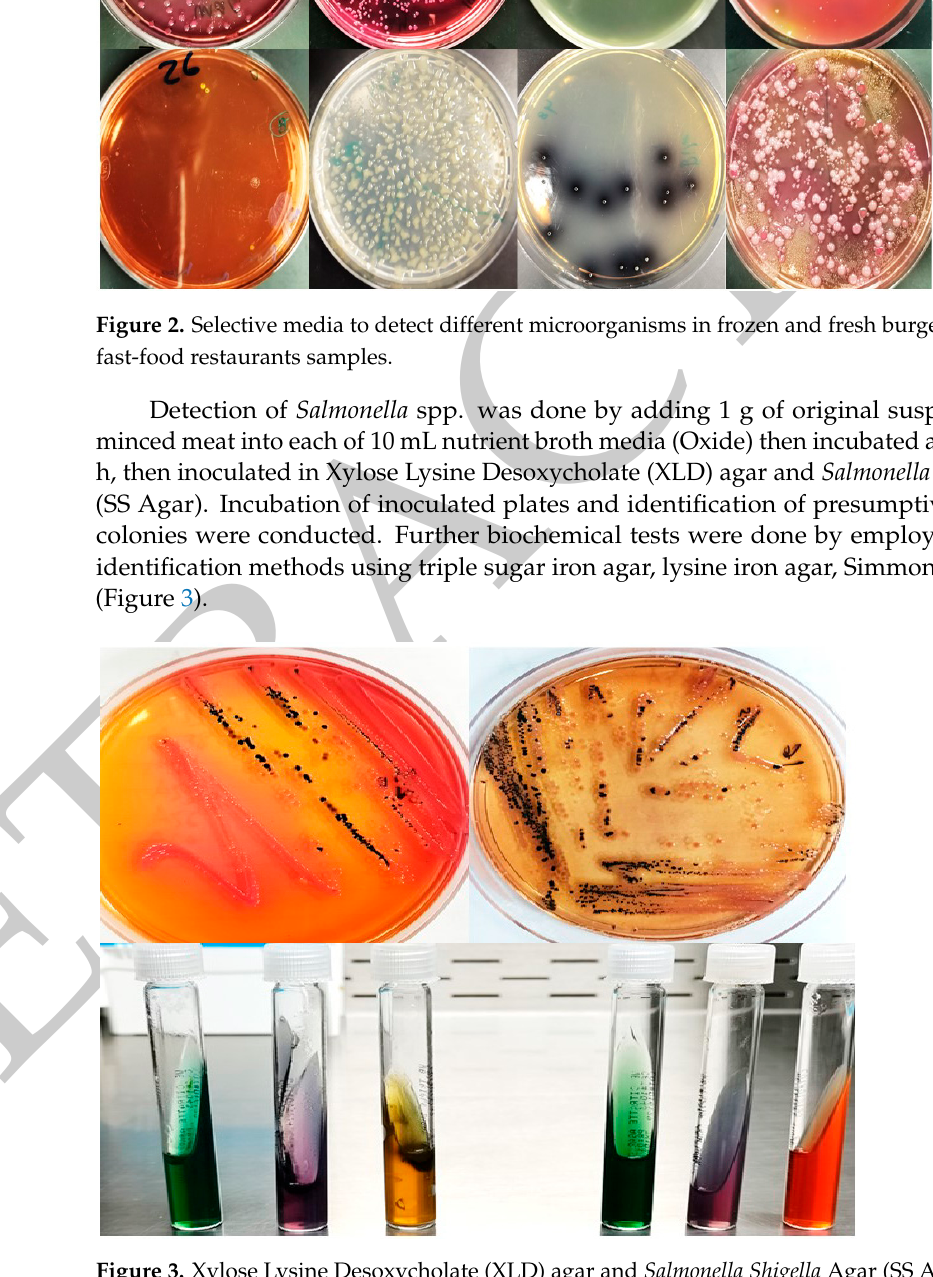
Figure 3. Xylose Lysine Desoxycholate (XLD) agar and Salmonella Shigella Agar (SS Agar) for detect Salmonella species and triple sugar iron agar test, lysine iron agar test, Simmons citrate agar